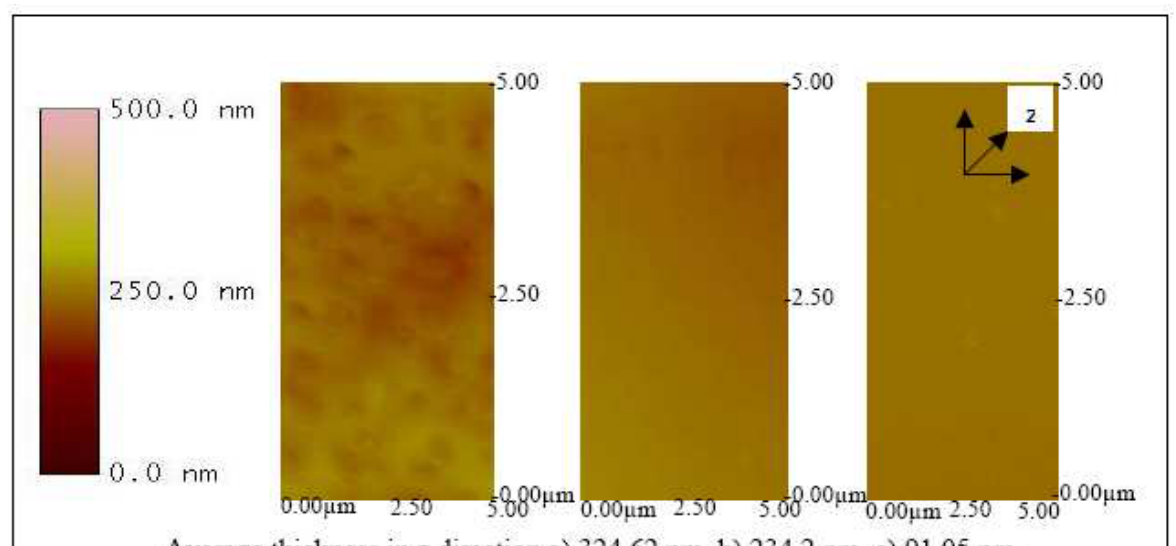
OH) and spin coated 4